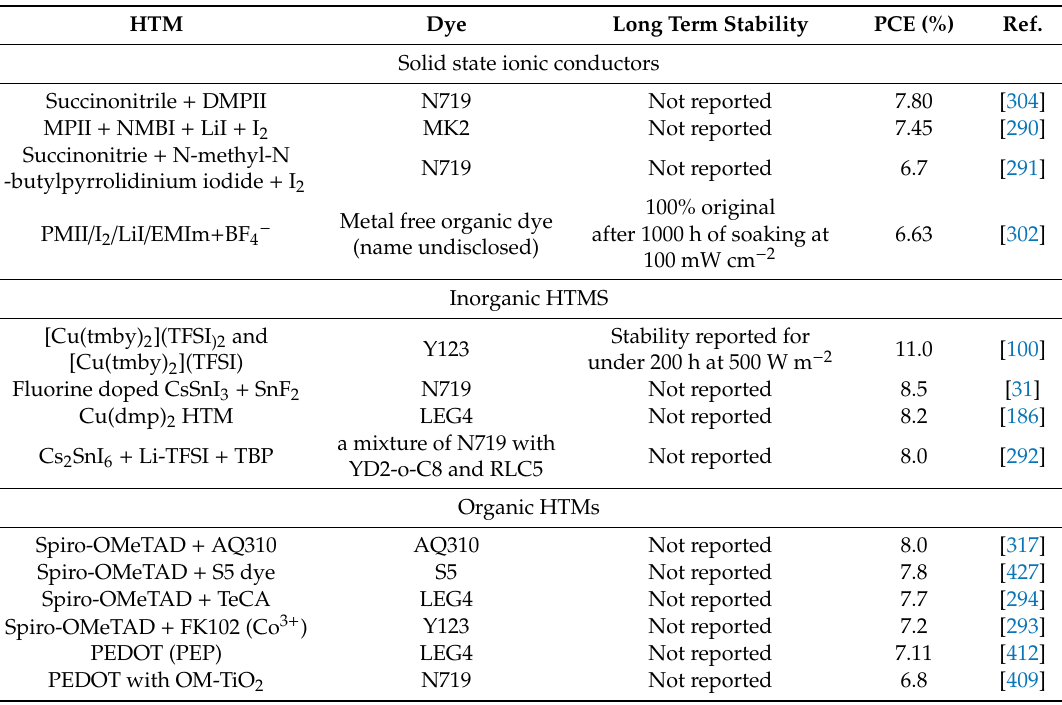
Table 8. Best e ffi ciencies reported for organic and inorganic hole-transporting materials (HTMs). HTM Dye Long Term Stability PCE (%) Ref. Solid state ionic conductors Succinonitrile + DMPII N719 Not reported Succinonitrie + N-methyl-N Not